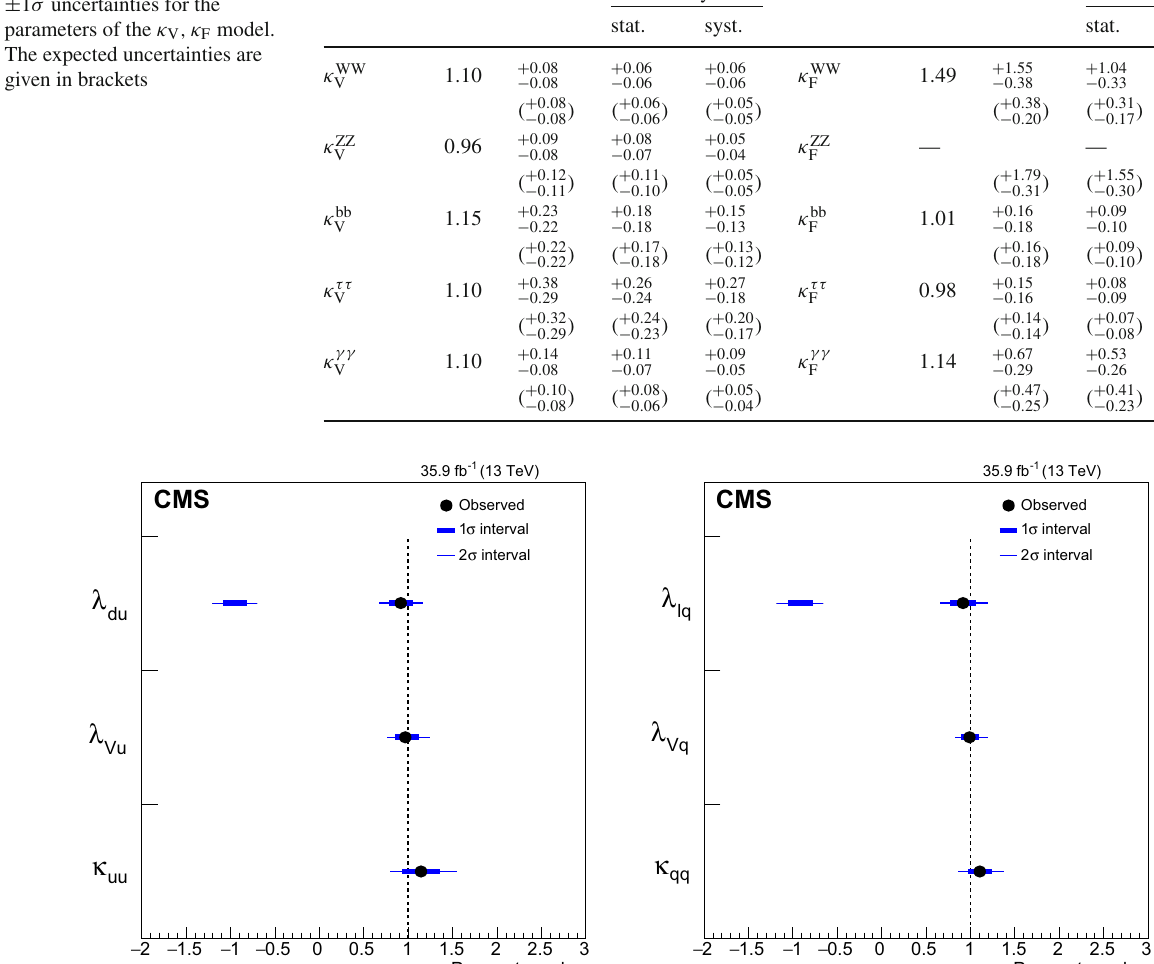
Table 10 Best fit values and ± 1 σ uncertainties for the parameters of the κ V ,κ F model. The expected uncertainties are given in brackets